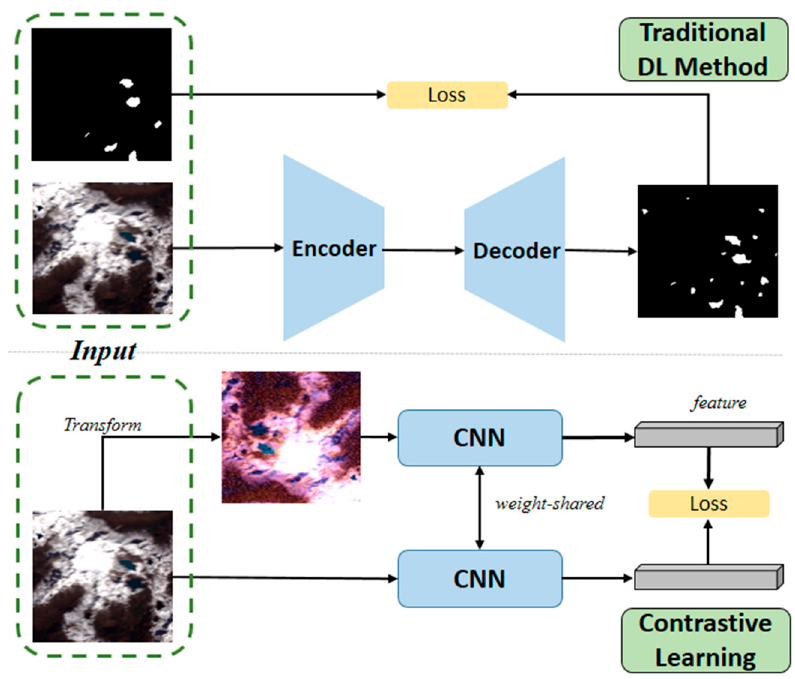
Figure 1. Different inputs and training strategies in contrastive learning and traditional deep learning (DL) methods in glacial lake mapping. DL methods always need to input labeled lake masks to construct the loss function, while contrastive learning calculates the loss function between the input image only and its augmentations.